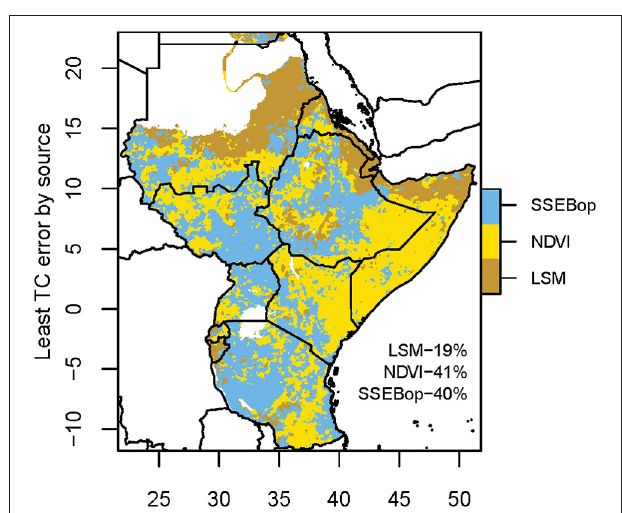
FIGURE 11 | Map of lowest TC error for LSM ET, SSEBop ET, and NDVI for the 2003–2016 period.